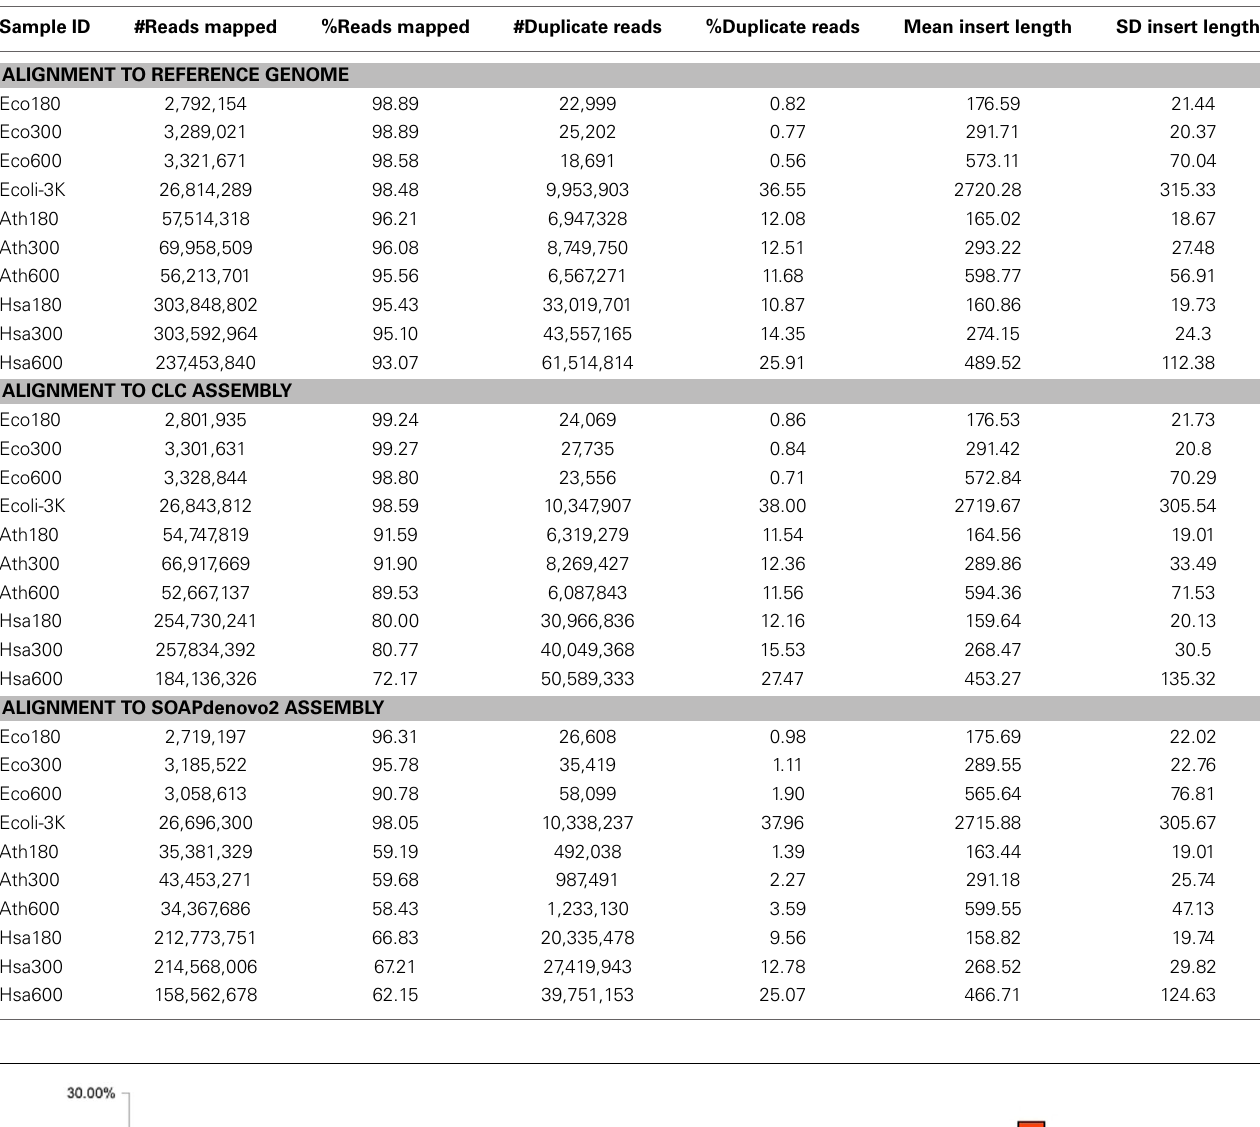
Table 3 | Mapping statistics for genomic libraries.